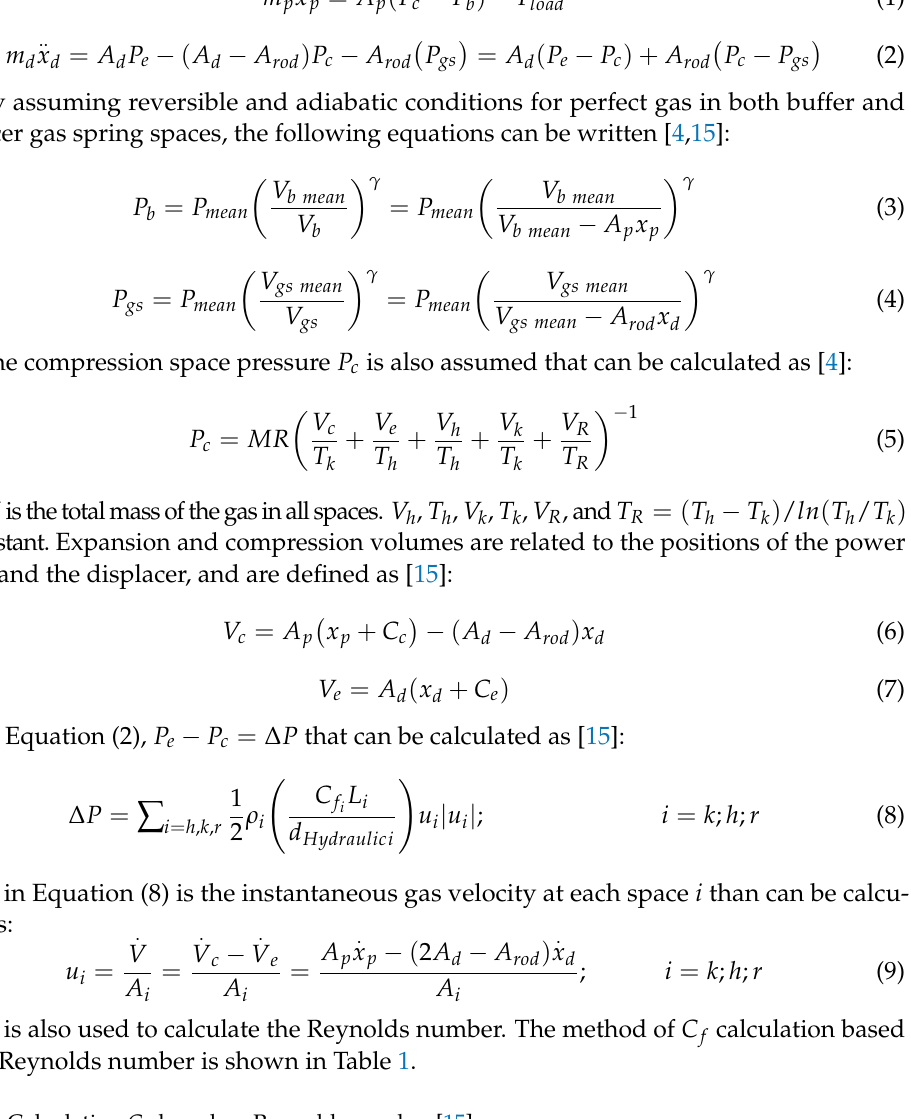
Table 1. Calculating C f based on Reynolds number